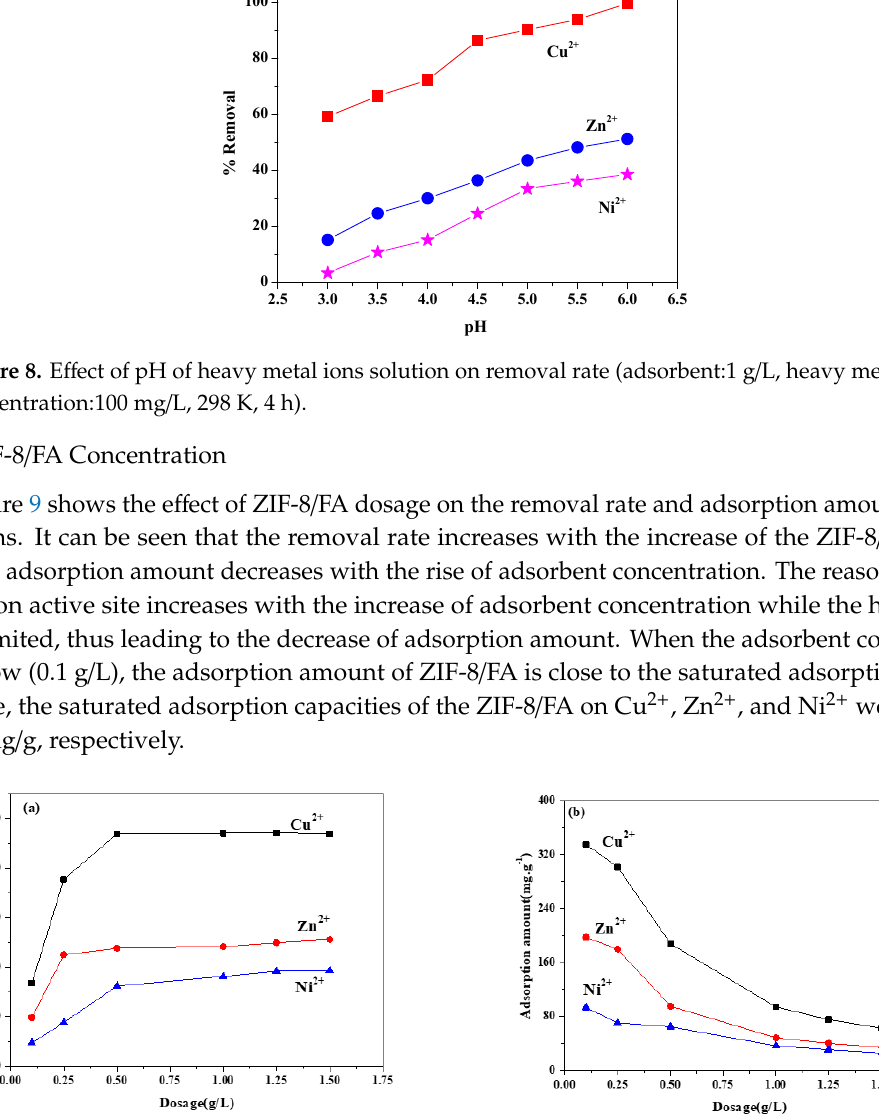
Figure 9. Effect of ZIF-8/FA dosage on ( a ) removal rate and ( b ) adsorption amount of heavy metal ions (heavy metal ions concentration:100 mg/L, 298K, 4 h, pH:5.5).